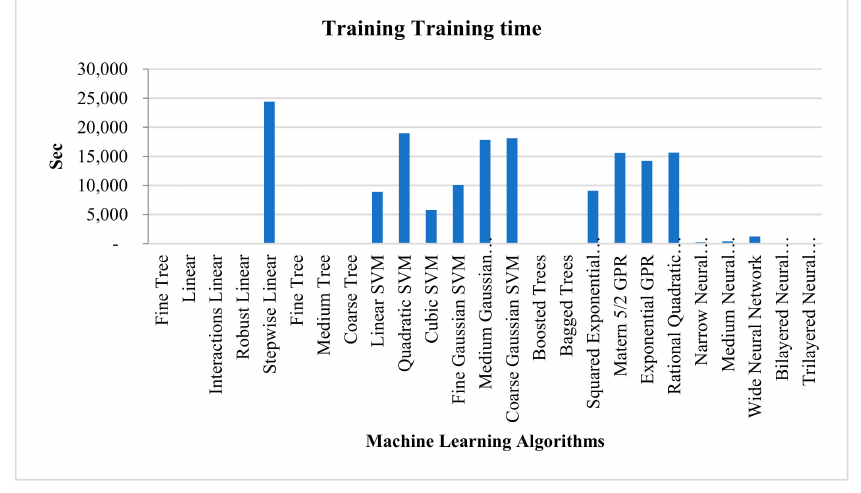
Figure 8. Training time.